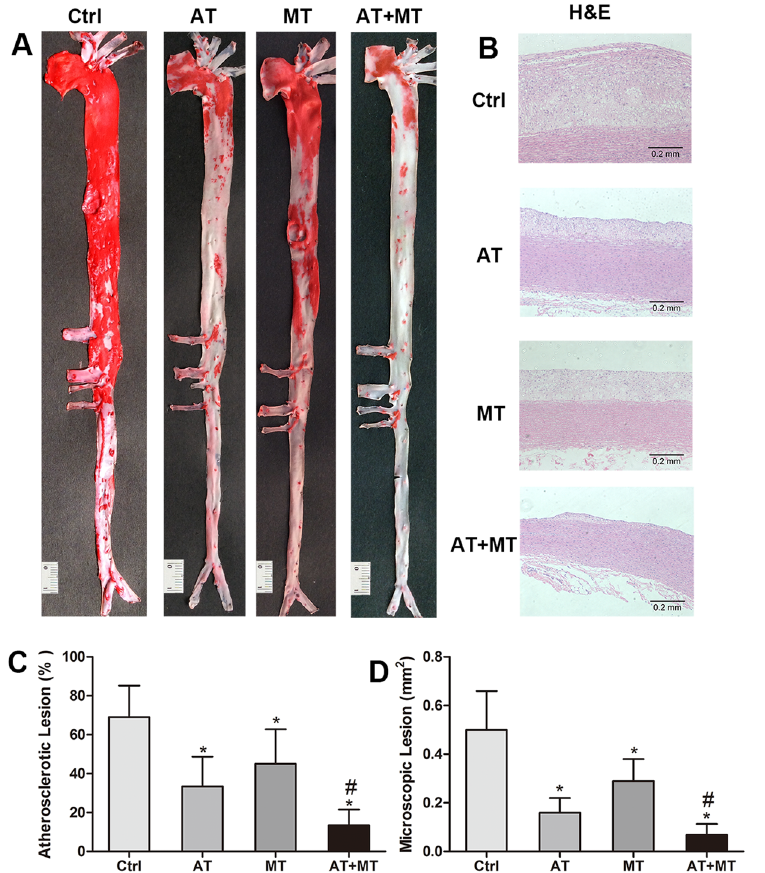
Figure 1. Atorvastatin/metformin combination therapy attenuates atherosclerotic plaques more effectively than monotherapy with either medication. At the end of the experiment, aortas between the aortic arch and the junction of the iliac arteries of rabbits were separated and stained with Oil Red O ( A ). To analyze microscopic atherosclerotic lesion, sections from the aortic arch were cut for paraffin sections and stained with H&E ( B ). Gross en face atherosclerotic lesion area of the whole aorta ( C ) and microscopic lesion area ( D ) were quantified by ImageJ software. Data are mean ± SD, n = 6 or 7 for each group. * P < 0.05, compared with Ctrl group; # P < 0.05, compared with AT group. Ctrl, control group; AT, atorvastatin group; MT, metformin group; AT + MT group, atorvastatin/metformin combination therapy